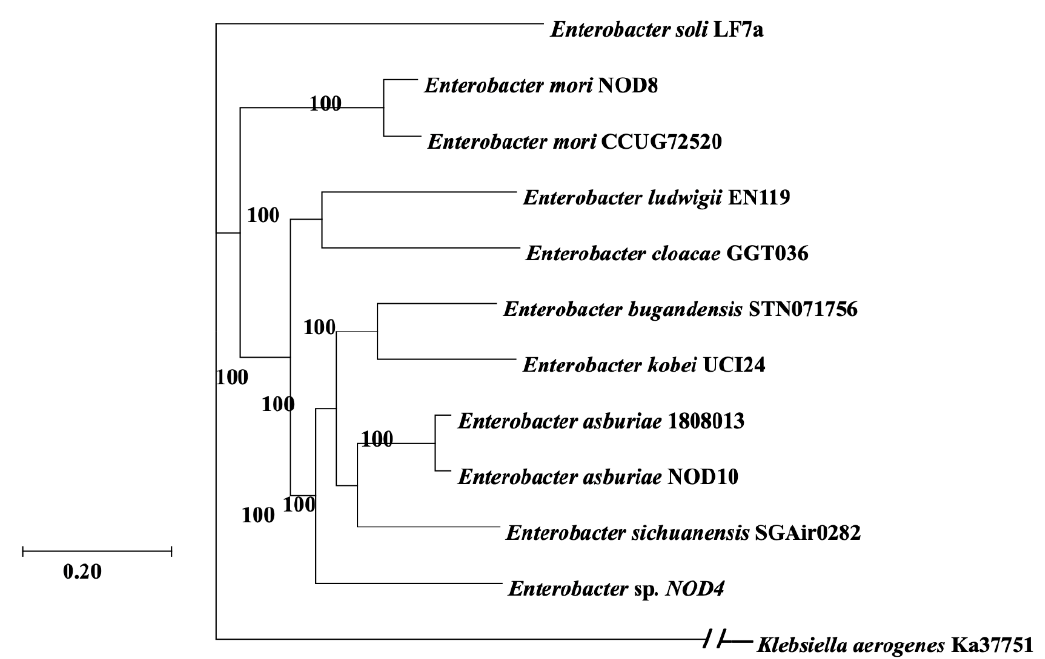
Figure 1. Molecular Phylogenetic Analysis of Enterobacter with rec A gene by Maximum Likelihood Method based on the General Time Reversible Model. The tree with the highest log likelihood ( − 3614.36) is shown. Initial tree(s) for the heuristic search were obtained automatically by applying Neighbor-Join and BioNJ algorithms to a matrix of pairwise distances estimated using the Maximum Composite Likelihood (MCL) approach, and then selecting the topology with superior log likelihood value. A discrete Gamma distribution was used to model evolutionary rate differences among sites (5 categories (+G, parameter = 0.1689)). The rate variation model allowed for some sites to be evolutionarily invariable ([+I], 39.76% sites). The tree is drawn to scale, with branch lengths measured in the number of substitutions per site. The analysis involved 18 nucleotide sequences. All positions containing gaps and missing data were eliminated. There was a total of 879 positions in the final dataset. Evolutionary analyses were conducted in MEGA